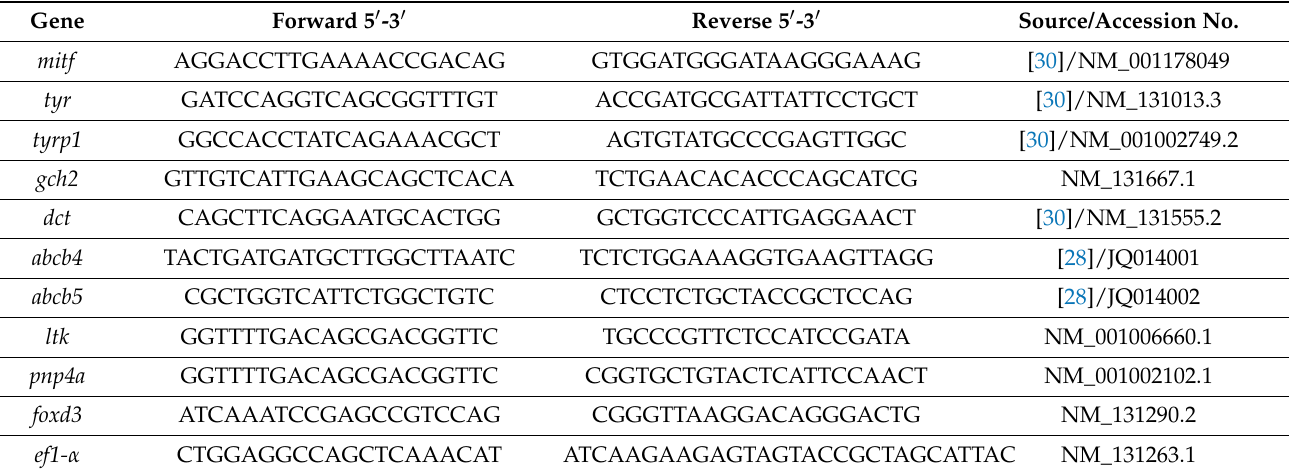
Table 1. Primers used in the